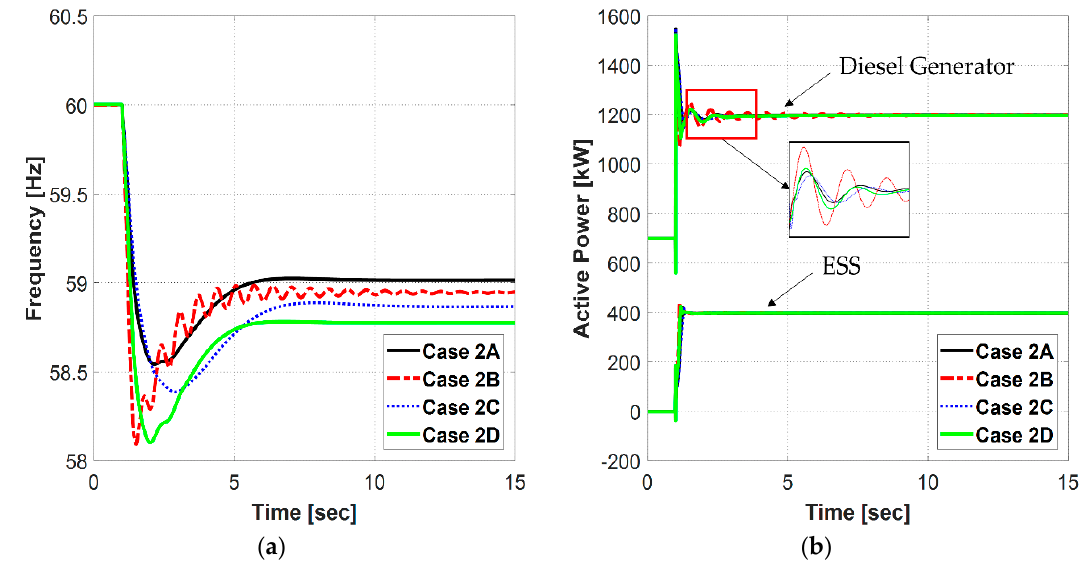
Figure 9. Results after the PV generation decreased from 906 kW to zero for Cases 2A–2D: ( a ) frequency response; ( b ) power output from the diesel generators and the ESS.